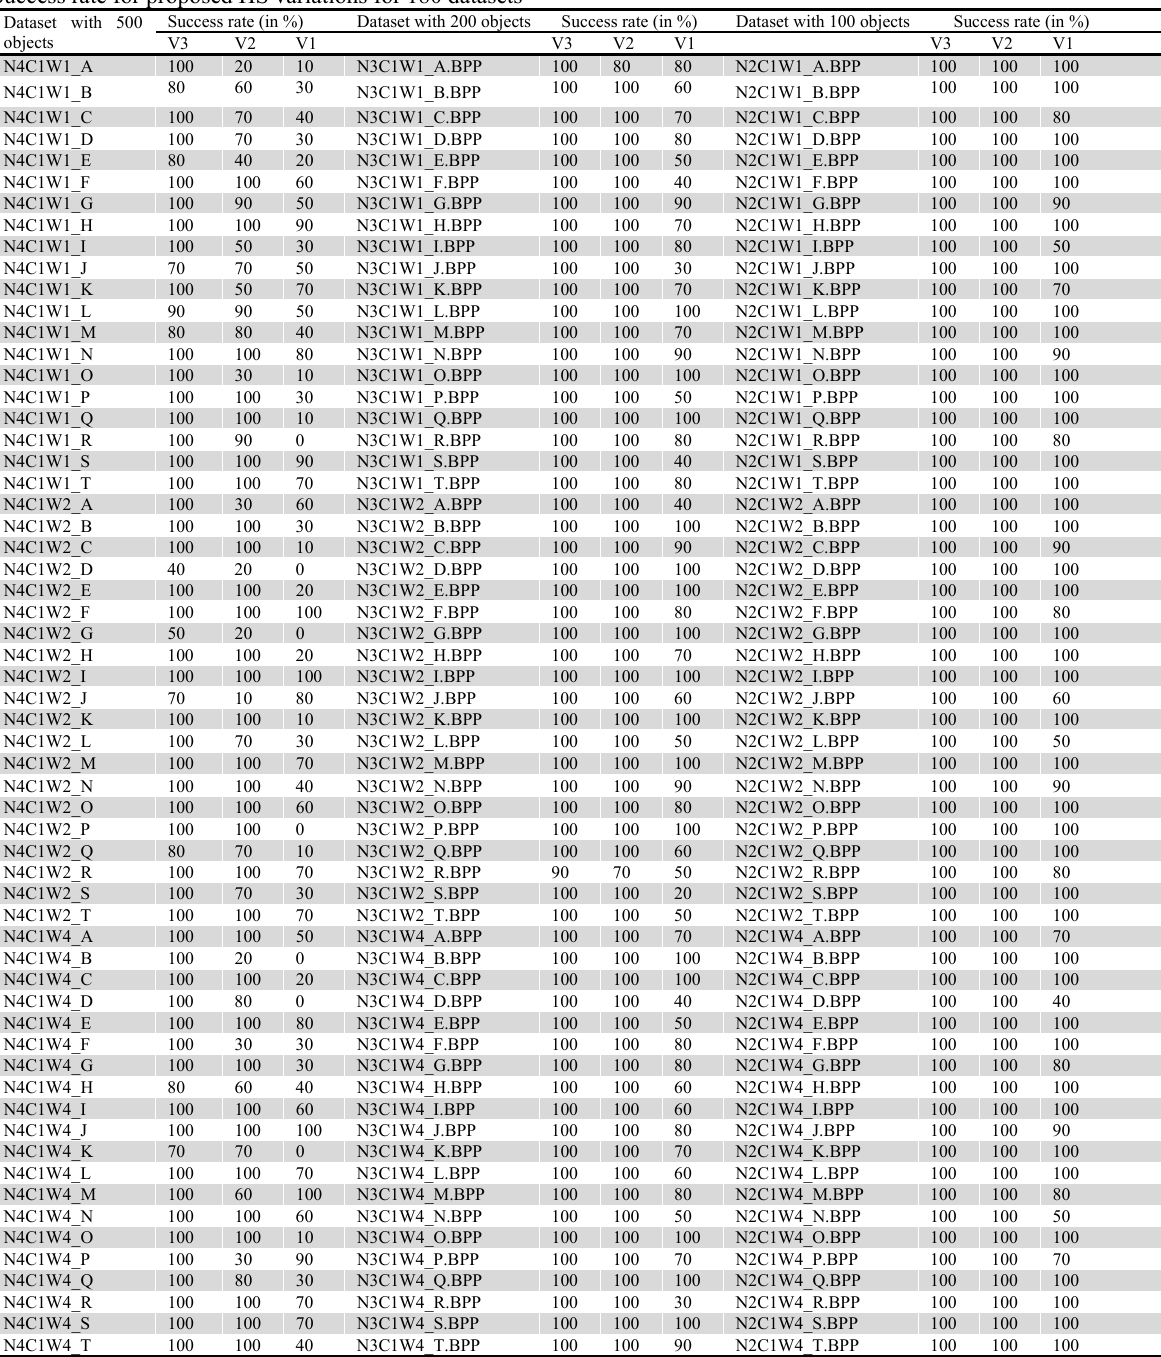
Success rate for proposed HS variations for 180 datasets Success rate (in %) Dataset with 200 Dataset with 500 objects